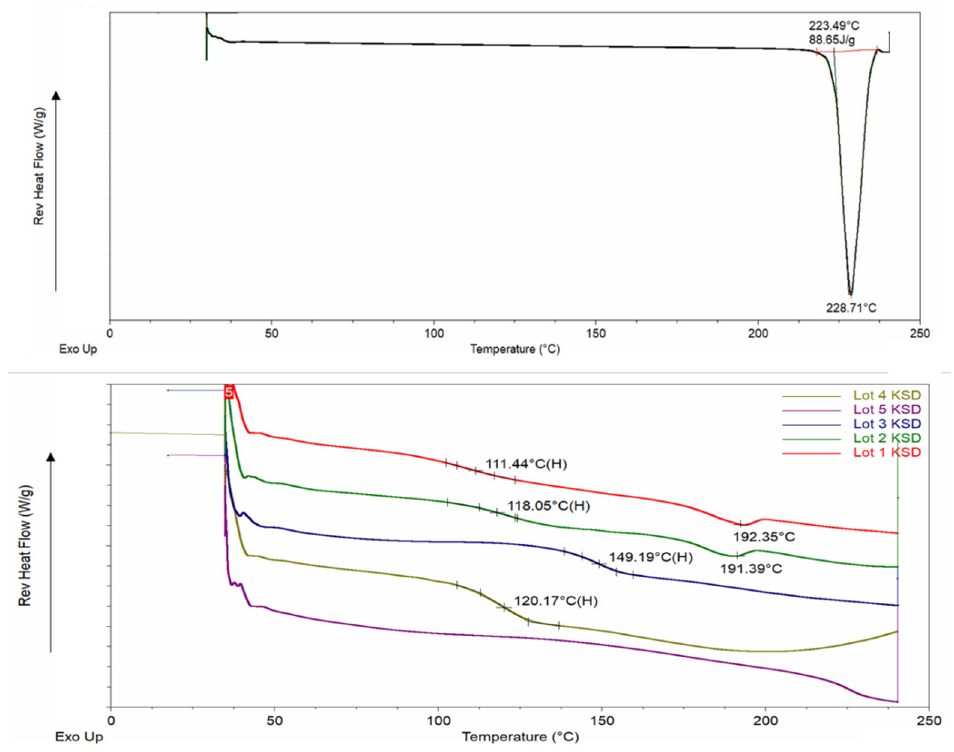
Figure 4. mDSC thermograms of abiraterone API (top) and abiraterone binary KSDs (bottom).